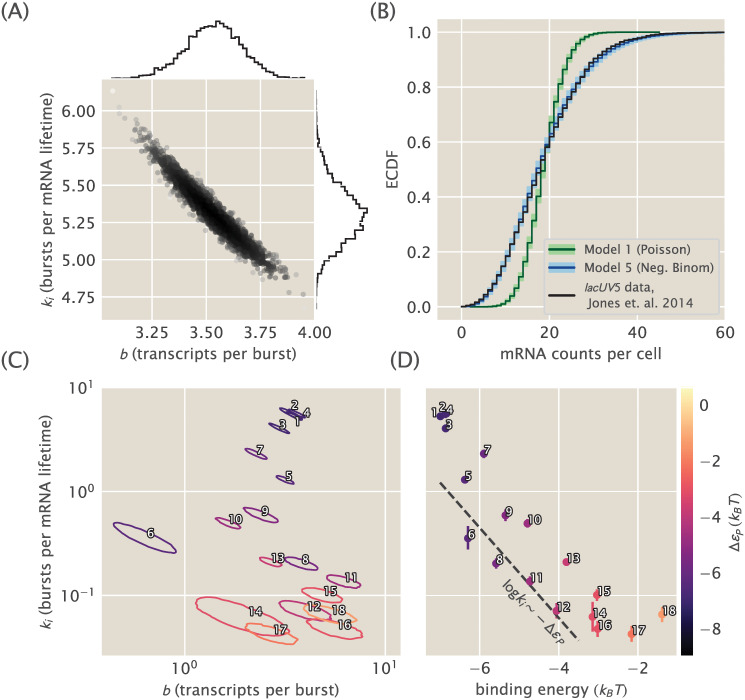
Constitutive promoter posterior inference and model comparison.(A) The joint posterior density of model 5, the bursty promoter with negative binomially-distributed steady state, is plotted with MCMC samples. 1D marginal probability densities are plotted as flanking histograms. The model was fit on lacUV5 data from [33]. (B) The empirical cumulative distribution function (ECDF) of the observed population distribution of mRNA transcripts under the control of a constitutive lacUV5 promoter is shown in black. The median posterior predictive ECDFs for models (1), Poisson, and (5), negative binomial, are plotted in dark green and dark blue, respectively. Lighter green and blue regions enclose 95% of all posterior predictive samples from their respective models. Model (1) is in obvious contradiction with the data while model (5) is not. Single-cell mRNA count data is again from [33]. (C) Joint posterior distributions for burst rate ki and mean burst size b for 18 unregulated promoters from [33]. Each contour indicates the 95% highest posterior probability density region for a particular promoter. Note that the vertical axis is shared with (D). (D) Plots of the burst rate ki vs. the binding energy for each promoter as predicted in [48]. The dotted line shows the predicted slope according to Eq 22, described in text. Each individual promoter is labeled with a unique number in both (C) and (D) for cross comparison and for comparison with Fig 2B.